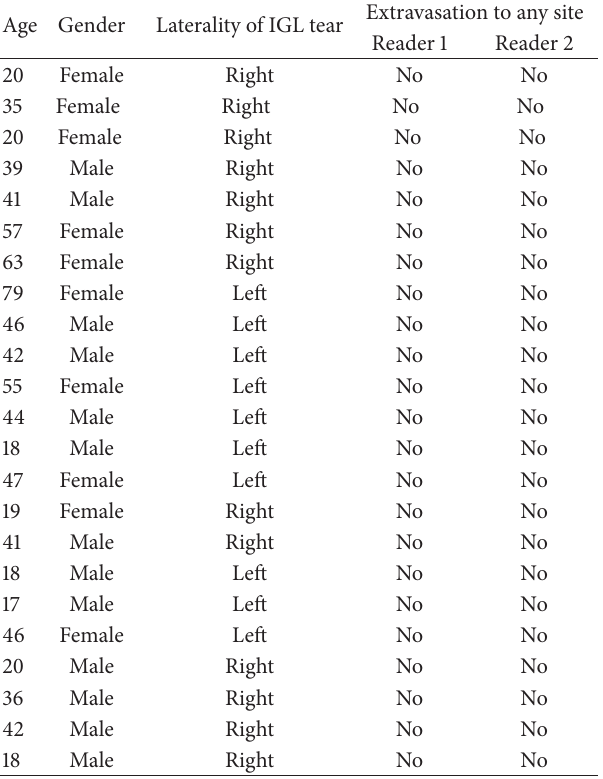
Table 3: Control group (all patients arthroscopically negative for HAGL